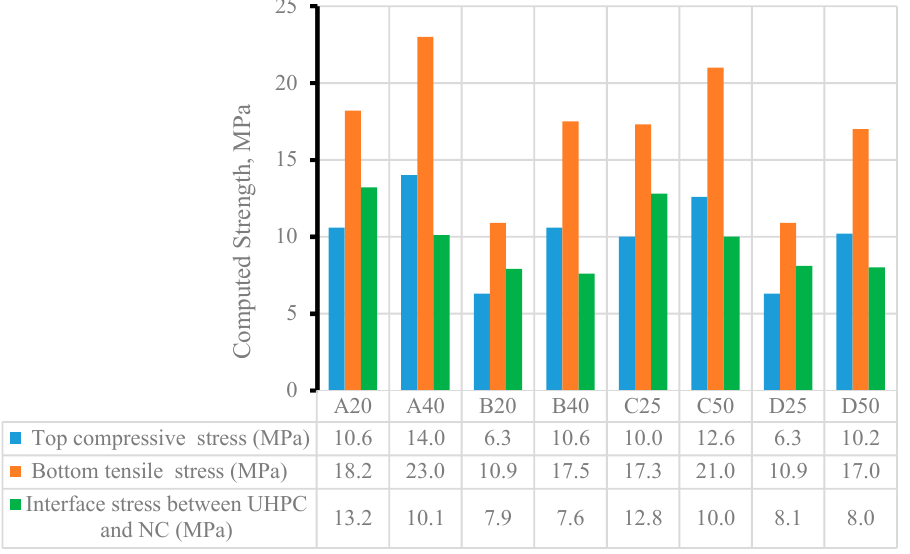
Figure 16. Experimental stresses in UHPC layer, at interface, bottom, and top of the hybrid beams.